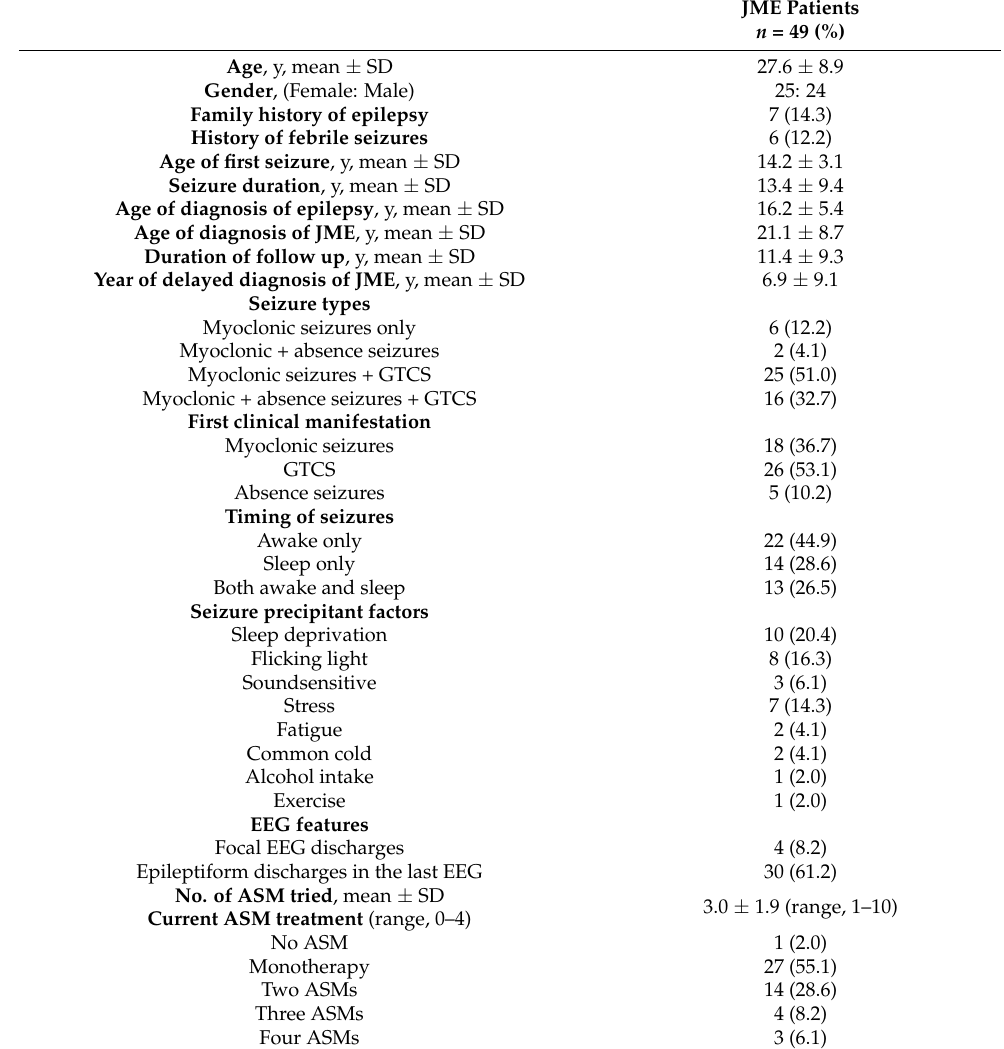
Table 1. Characteristic of patients diagnosed with